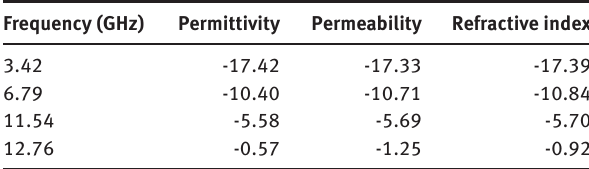
Table 2: Double-negative properties of the unit